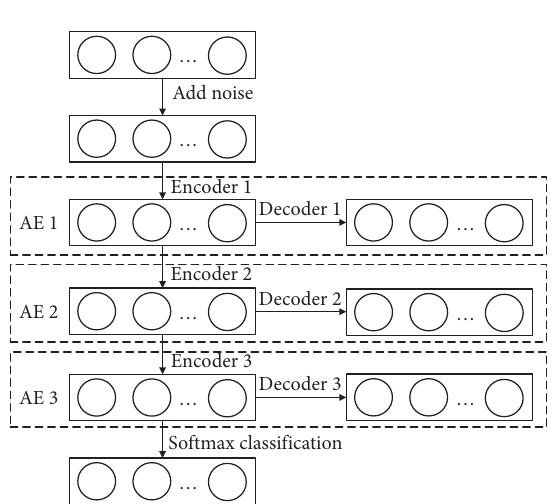
Figure 5: Stacked denoising autoencoder network